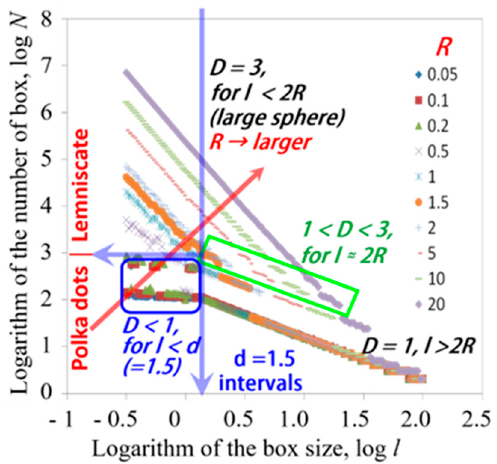
Figure 8. The box size versus number of boxes with spheres. Plots obtained for the radius R show straight lines with a change in the slope. The straight lines locate from the below left to the upper right in the figure with increasing R from 0.05 to 20.